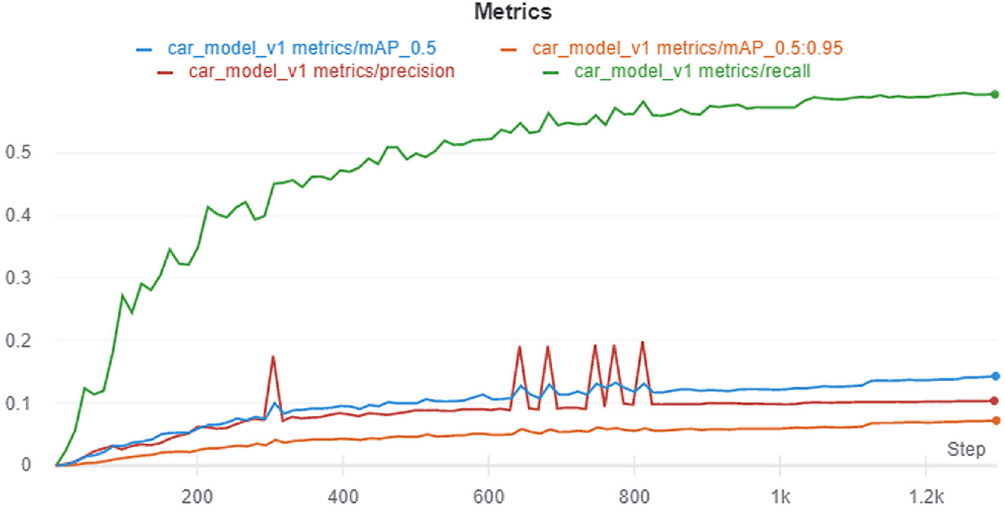
Figure 13. Loses for different